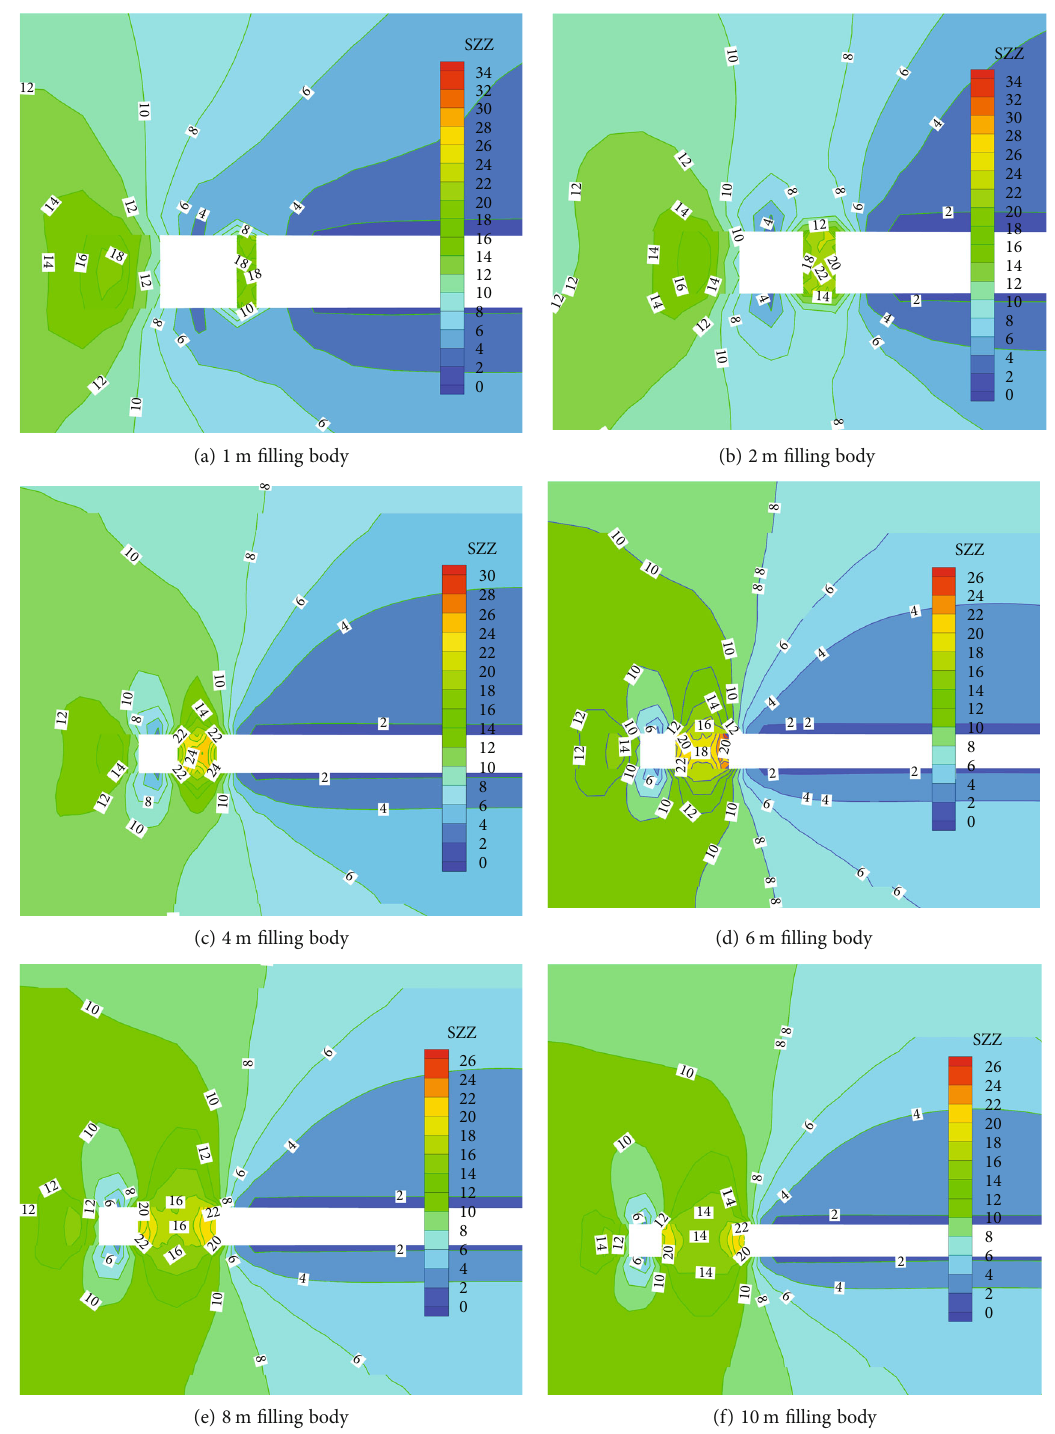
Figure 6: Vertical stress distribution of di ff erent fi lling body